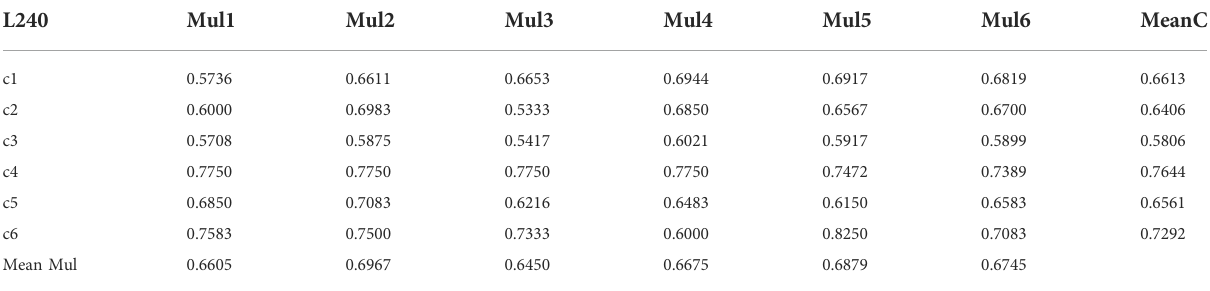
TABLE 4 The mean results of each multilayer network of the six crises in the 240-day window.